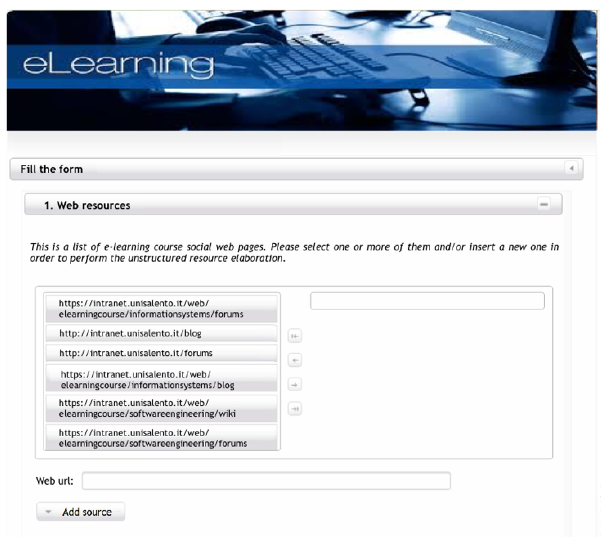
Figure 2: Web source selection and insert form